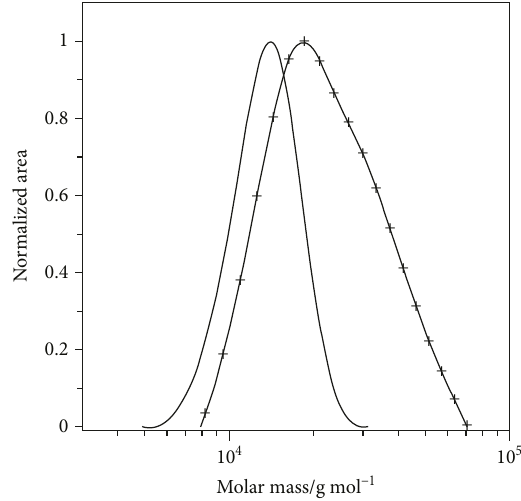
Figure 3: SEC chromatogram of PDMS homopolymer and P (DMS- b - ε -CL) SCL4 block copolymer. Symbols: ( − ) PDMS and ( + )